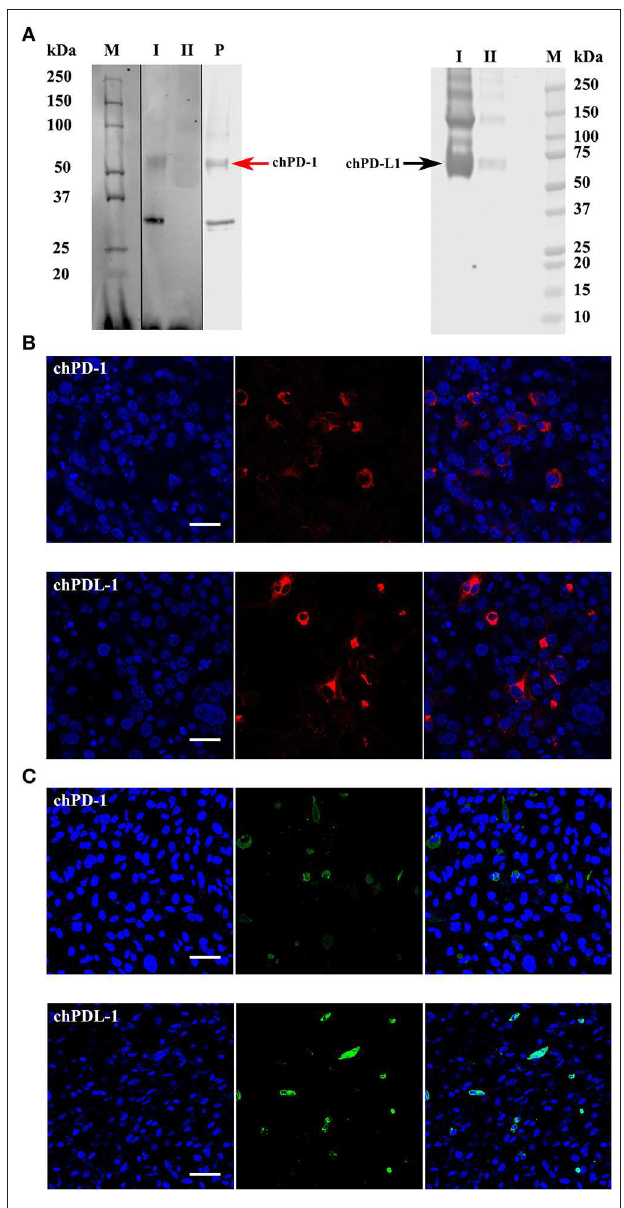
FIGURE 3 | Western blots and confocal micrographs of chPD-1 and chPD-L1. (A) The extracellular soluble domains of chPD-1 and chPD-L1 were sub cloned into pkW06 expression vector and expressed as a human Fc-tagged protein, namely, pKW06-chPD-1-human-IgG1Fc and pKW06-chPD-L1-human-IgG1Fc. Proteins were resolved on an SDS 4–12% Bis-Tris gel along with 10% of input protein and western blotted with monoclonal anti-chPD-1 and chPD-L1 antibodies. Images demonstrate that ∼ 55 kDa (red arrow left direction) for chPD-1 and a band of ∼ 70 kDa (black arrow right direction) for chPD-L1. I is purified sample, II is supernatant from transfected cells and P is commercial positive control. Dividing black line indicates that intervening lanes have been spliced out. (B,C) Representative confocal micrographs illustrating chPD-1 and chPD-L1 in COS (left) and DF-1 (right) cells. Immunofluorescence staining was carried out on COS and DF-1 cells transfected with expression constructs containing pKW06-chPD-1-human-IgG1Fc and pKW06-chPD-L1-human-IgG1Fc plasmids. Cells were fixed after 24–48h and stained with monoclonal anti-chPD-1 (A) and chPD-L1 (B) antibodies. Scale bar represents 40 µ